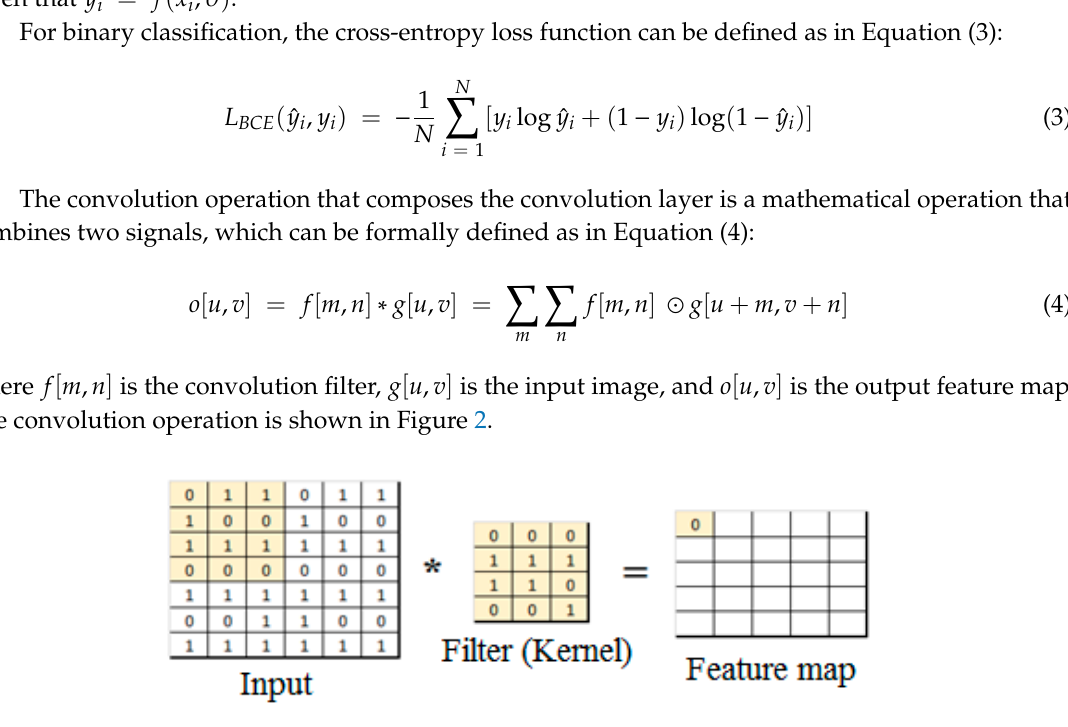
Figure 2. Convolutional operation.